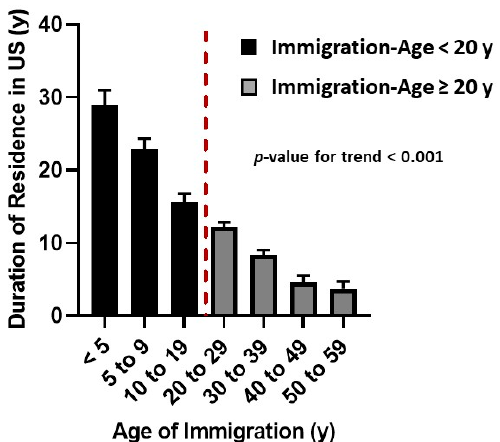
Figure 2. Duration of Residence in the United States by Age of Immigration. Dash red line separates the group who immigrated before age 20 y from the group who immigrated at 20 y or older.